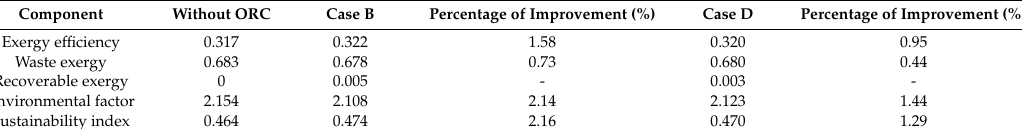
Table 7. Exergetic sustainability factor of the engine with and without ORC.